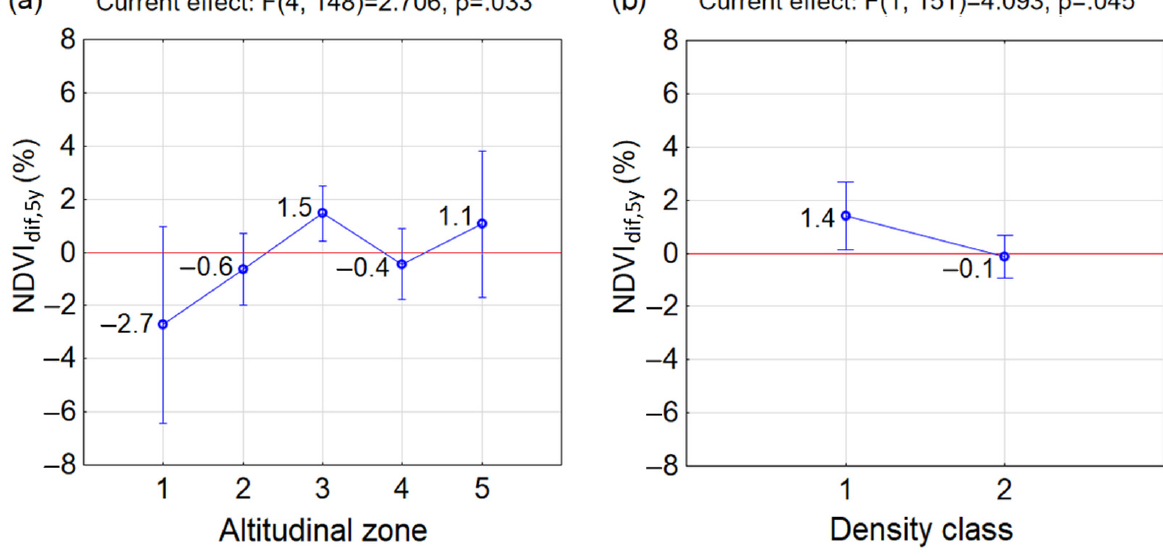
Figure 8. Change of vegetation greenness of P. mugo between the end (2016–2020) and the beginning (2000–2004) of the studied period ( a ) in each altitudinal zone and ( b ) in density classes. The blue circle marks the group average and the vertical bars denote the 0.95 confidence intervals. The positive values indicate the increase of NDVI in 2016–2020 compared to 2000–2004 and vice versa.